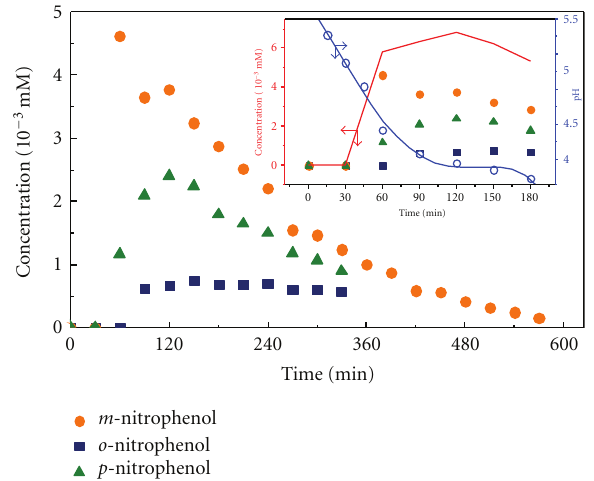
Figure 7: The concentration changes of intermediates m -, o -, p - nitrophenol as time changes. The photodegradation processes were operated with 1.626 mM nitrobenzene and 1.0g TiO 2 at pH 7 and 30 ◦ C with the air feeding of 150 mLmin − 1 for 10 h. Inset shows the relationship between pH changes and the total concentration of intermediates (in red line) for the initial 3 h of